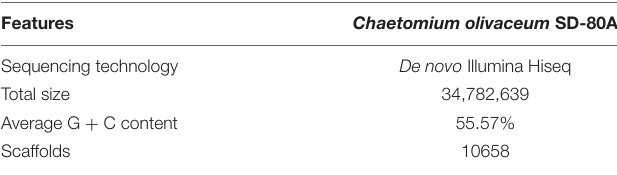
TABLE 1 | The features of the Chaetomium olivaceum SD-80A genome.